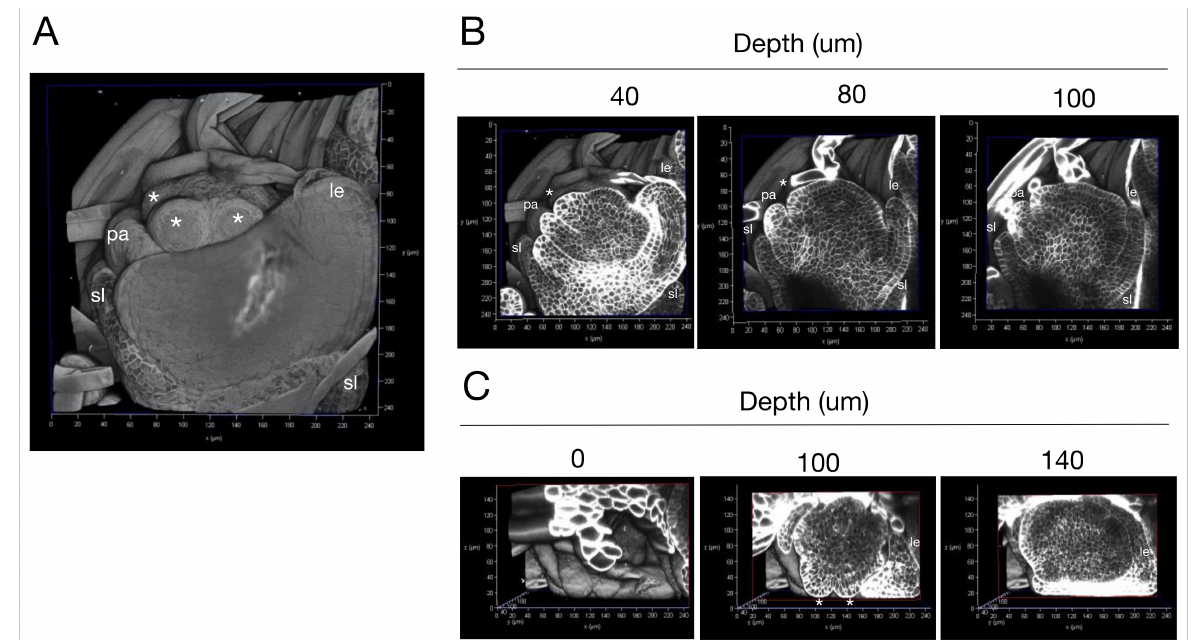
Figure 3. ( A ) A 3D-reconstructed rice floret. ( B ) Longitudinal sections of the floret. Confocal optical sections from the reconstructed image were arranged according to their depth from the first section of serial imaging. ( C ) Transverse sections of the 3D-reconstructed floret. The transverse sections were arranged according to the depth from the top of the reconstructed image shown in ( A